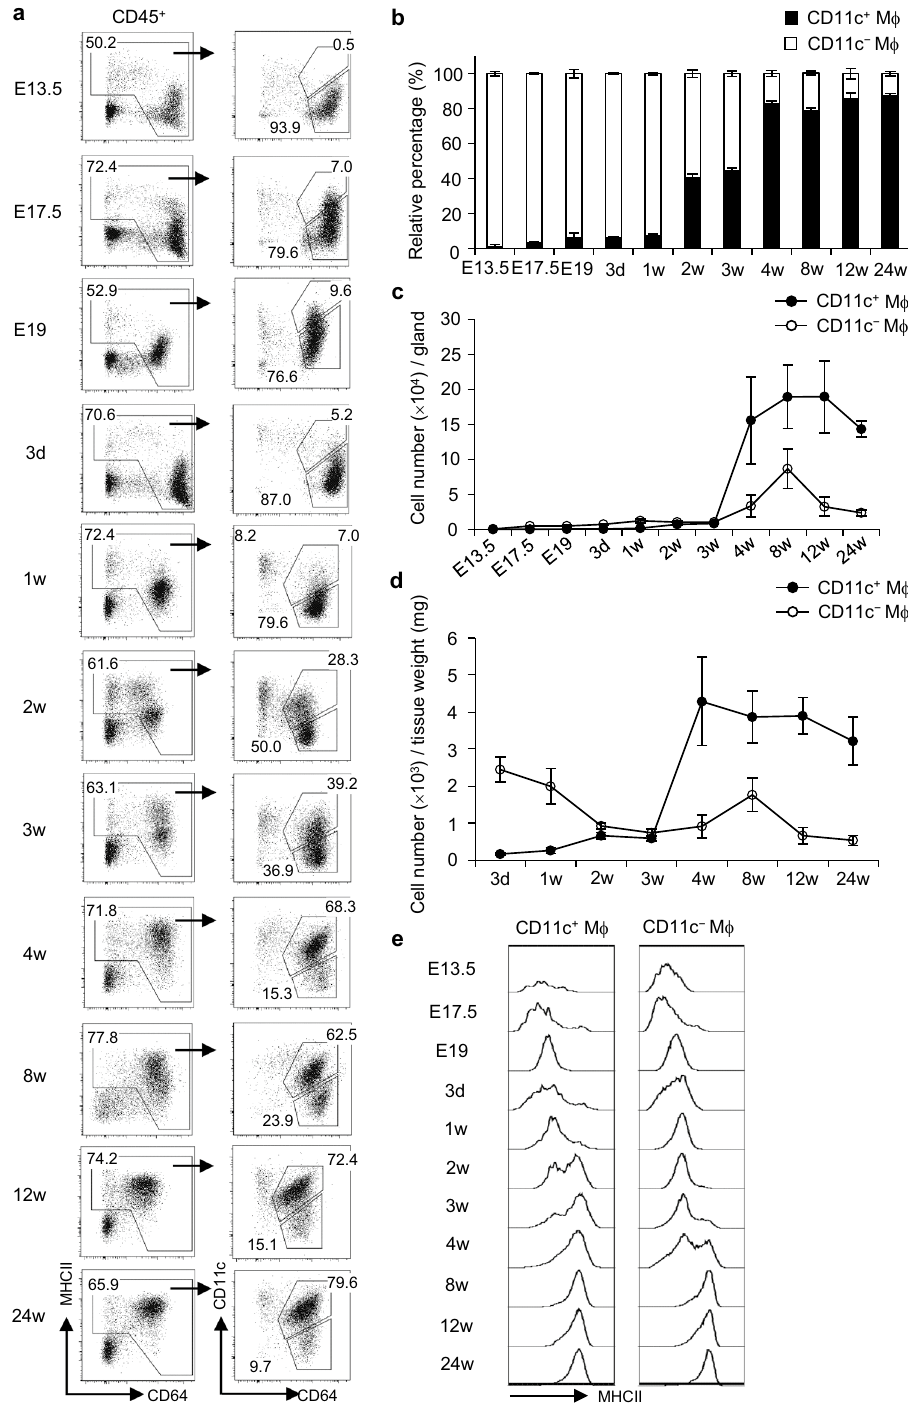
Figure 3. Age-dependent transition of macrophage subsets in steady-state SMGs. ( a – e ) Macrophage subsets in steady-state SMGs from mice at E13.5, E17.5, and E19 (embryo) and at 3 days (newborn) and 1, 2, 3, 4, 8, 12, and 24 weeks after birth were analyzed by flow cytometry. Representative FACS plots ( a ), the proportion of CD11c + and CD11c − macrophages ( b ), cell numbers per gland ( c ), cell numbers per tissue weight ( d ), and representative histograms for the expression of MHCII ( e ) are shown. Bars represent the mean ± SD ( n = 3). Results are representative of three independent experiments. Mϕ